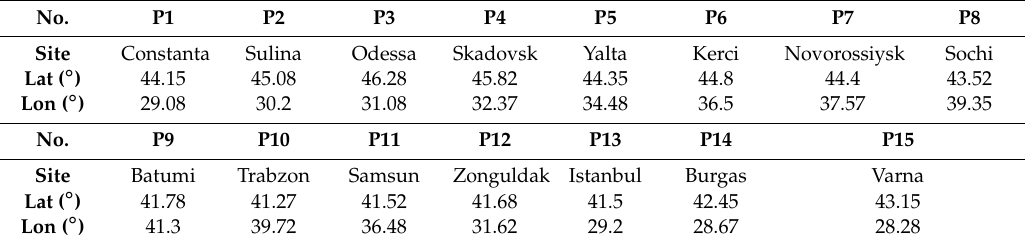
Figure 1. The locations of the reference points selected for the Black Sea coastal environment. Table 1. Locations of the considered sites (P1–P15).